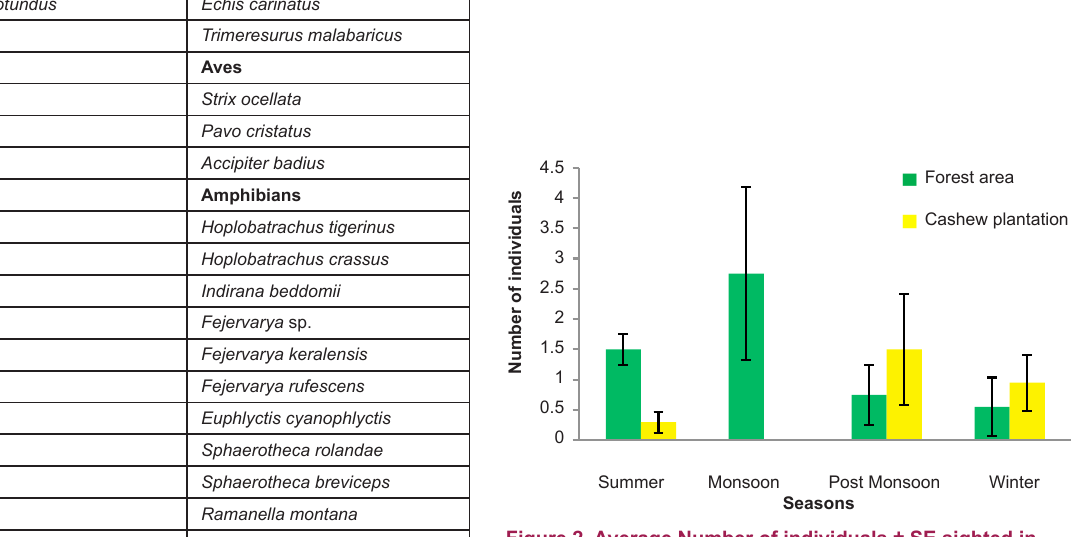
Figure 2. Average Number of individuals ± SE sighted in the forest area and cashew plantations during different